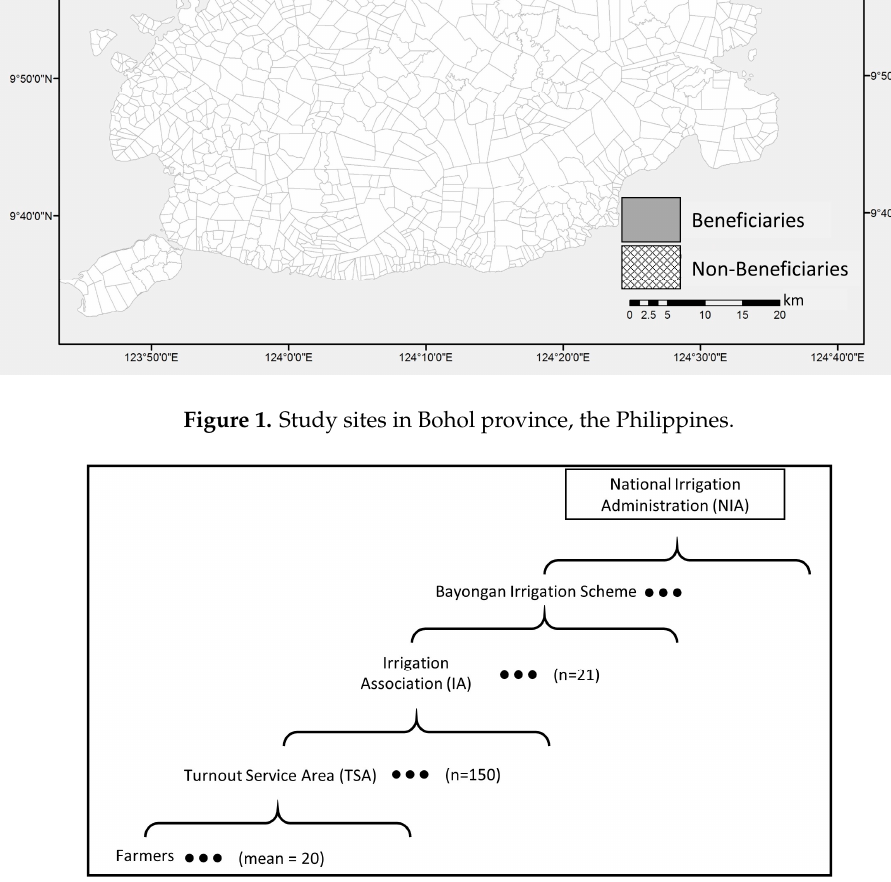
Figure 2. Organizational structure of National Irrigation Administration (NIA), Irrigation Associations (IA) and Turnout Service Areas (TSA).